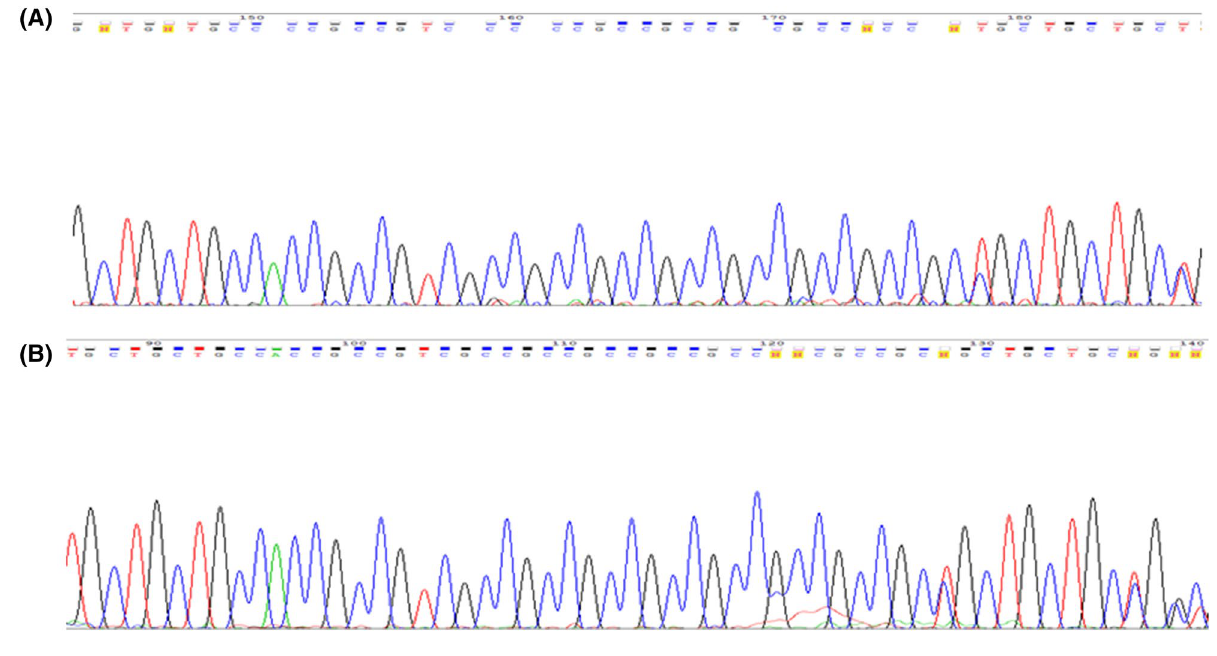
Figure 2. Two cases of late-onset NCD with 7/8